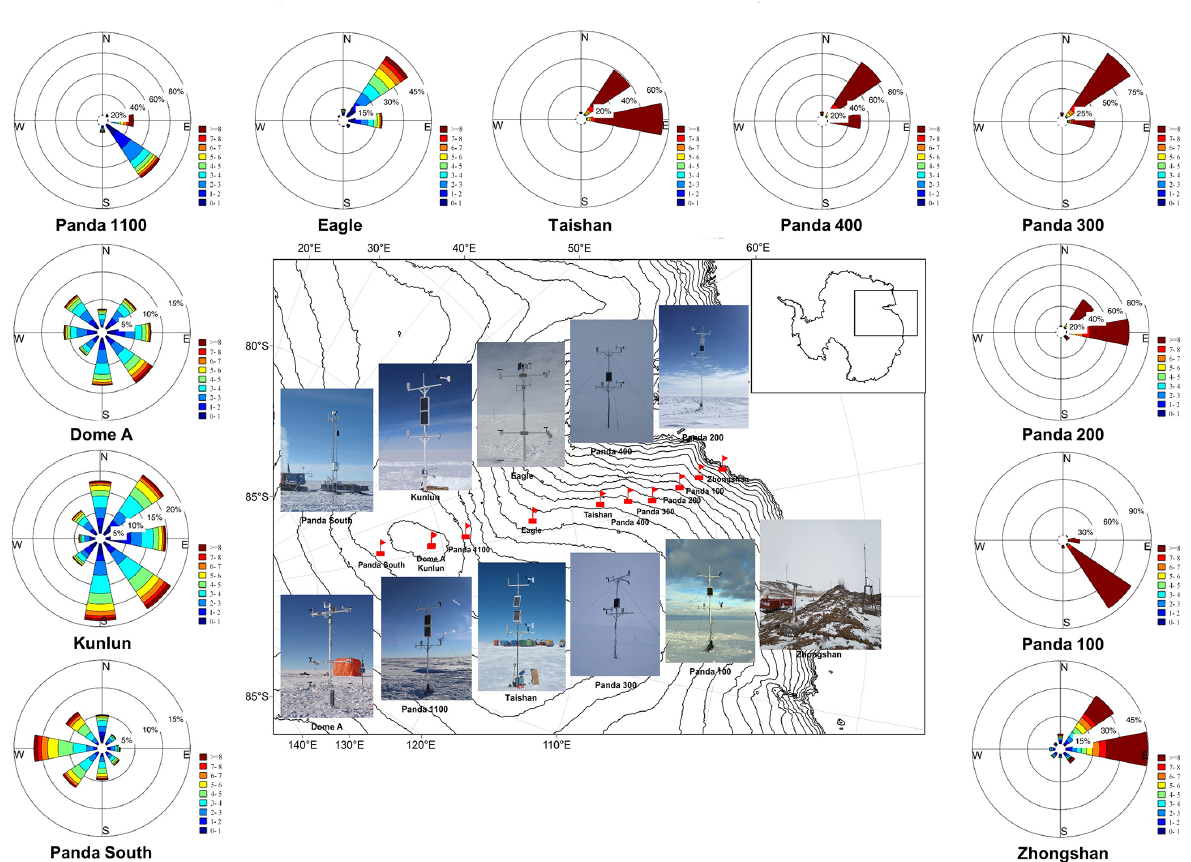
Figure 1. The location and wind roses of AWSs in the PANDA network. The red flags are AWSs; the solid black lines are 200m interval con- tours. The wind directions are divided into 22.5 ◦ sectors. Zhongshan is calculated during 1989–2020; Panda 100, Panda 300 and Panda 400 are calculated during 2019–2021; Panda 200 is calculated during 2016–2021; Taishan is calculated during 2012–2021; Eagle and Dome A are calculated during 2005–2020; Kunlun is calculated during 2017–2021; and Panda S is calculated during 2008–2021. Note however that, because some winter data were unreliable, Eagle averages exclude March–August, Dome A averages exclude March–October and Panda S averages exclude